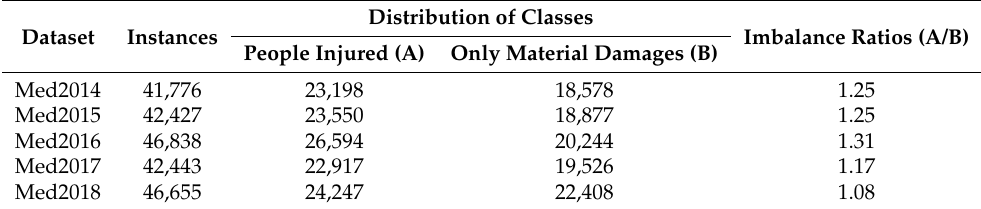
Table 6. Medellín case study: Description of Binary datasets.